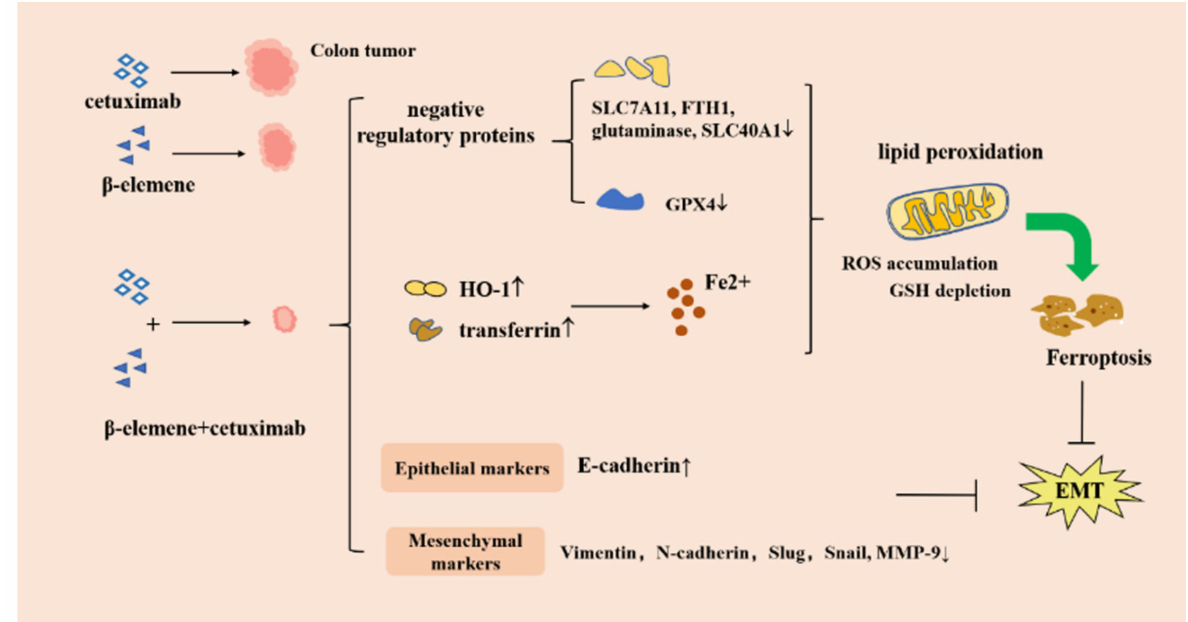
Figure 8. Mechanism of β -elemene inhibition of epithelial–mesenchymal transformation. The symble ↑ indicates upregu- lated expression. The symble ↓ indicates downregulated